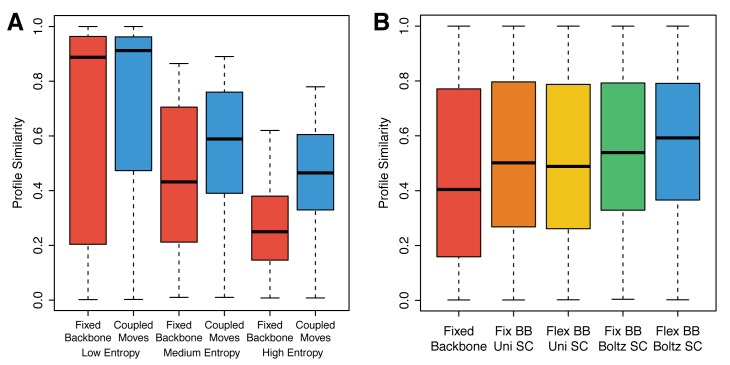
Sequence profile similarity distributions for different subsets of positions and for variations of the coupled moves method.A) Boxplots of profile similarity distributions for fixed backbone and coupled moves methods separated into three equal-sized groups based on sequence entropy in the natural sequences. B) Boxplots of profile similarity distributions for fixed backbone design and variations of the coupled moves method. Variants include using a Boltzmann distribution (“Boltz SC”) or a uniform distribution (“Uni SC”) to select mutations and side-chain conformations, and incorporating backbone flexibility (“Flex BB”) or using a fixed backbone (“Fix BB”).